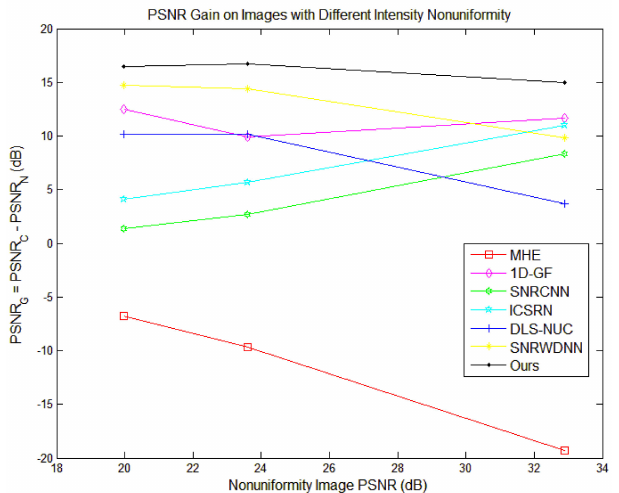
Figure 11. The PSNR gain of each method on images with different intensities of nonuniformity. The greater the PSNR along the abscissa direction, the lower the intensity of image